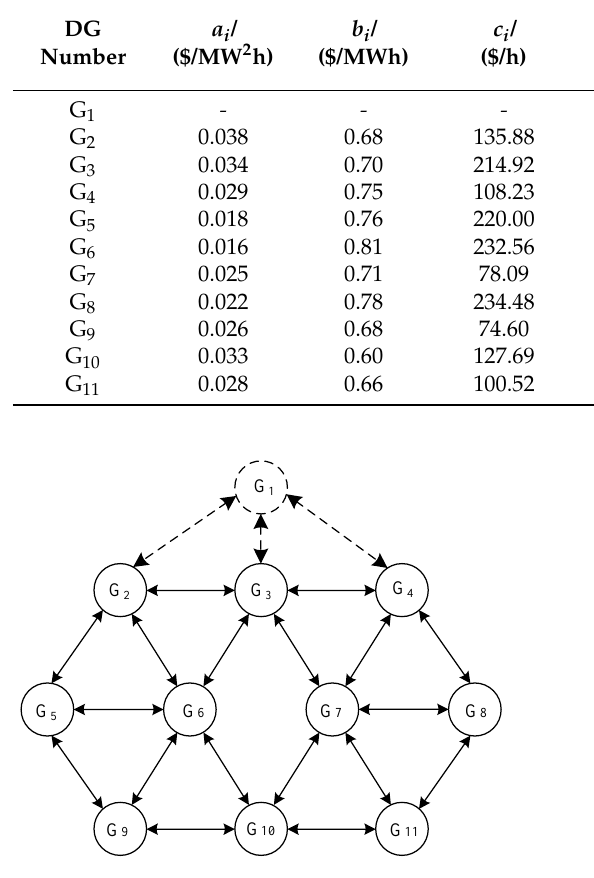
Figure 8. Communication network topology of the IEEE-39 system. (1) At p = 0.9 and t = 2 s, the system load increases by 200 MW from an initial 3420 MW, and decreases by 250 MW at t = 4 s. The response of the distributed economic dispatch system is shown in Figure 9.